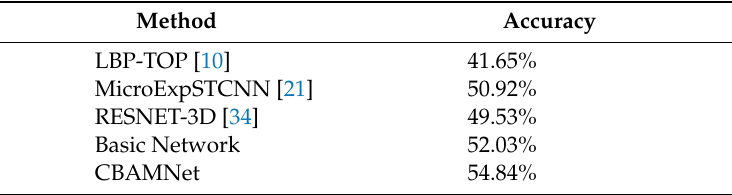
Table 5. Comparison of average recognition rates of di ff erent methods.